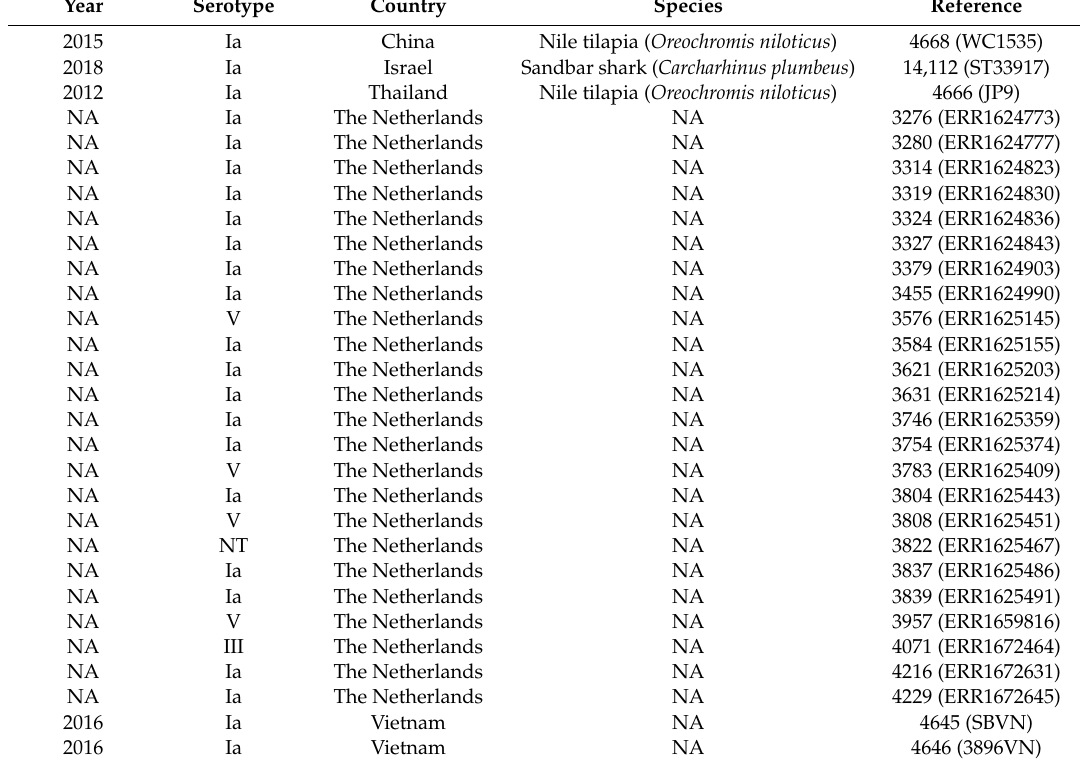
Table 1. Whole genome sequencing (WGS) of Streptococcus agalactiae available on pubMLST by